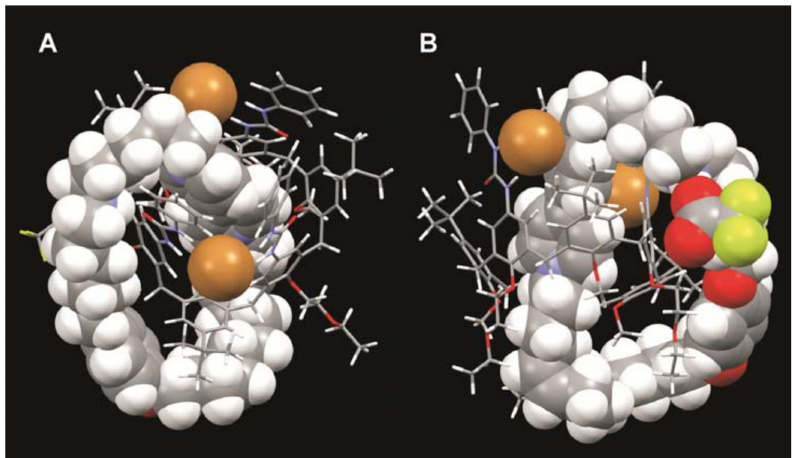
Figure 3. Two perspective views of the minimized structure (molecular mechanics, MMFF94s force field) of [2]catenane 3 . To appreciate the features of the interlocked structure, the calix[6]arene wheel and the bipyridinium-containing macrocycle (together with the anions) are rendered with the stick and the space-filling modes,